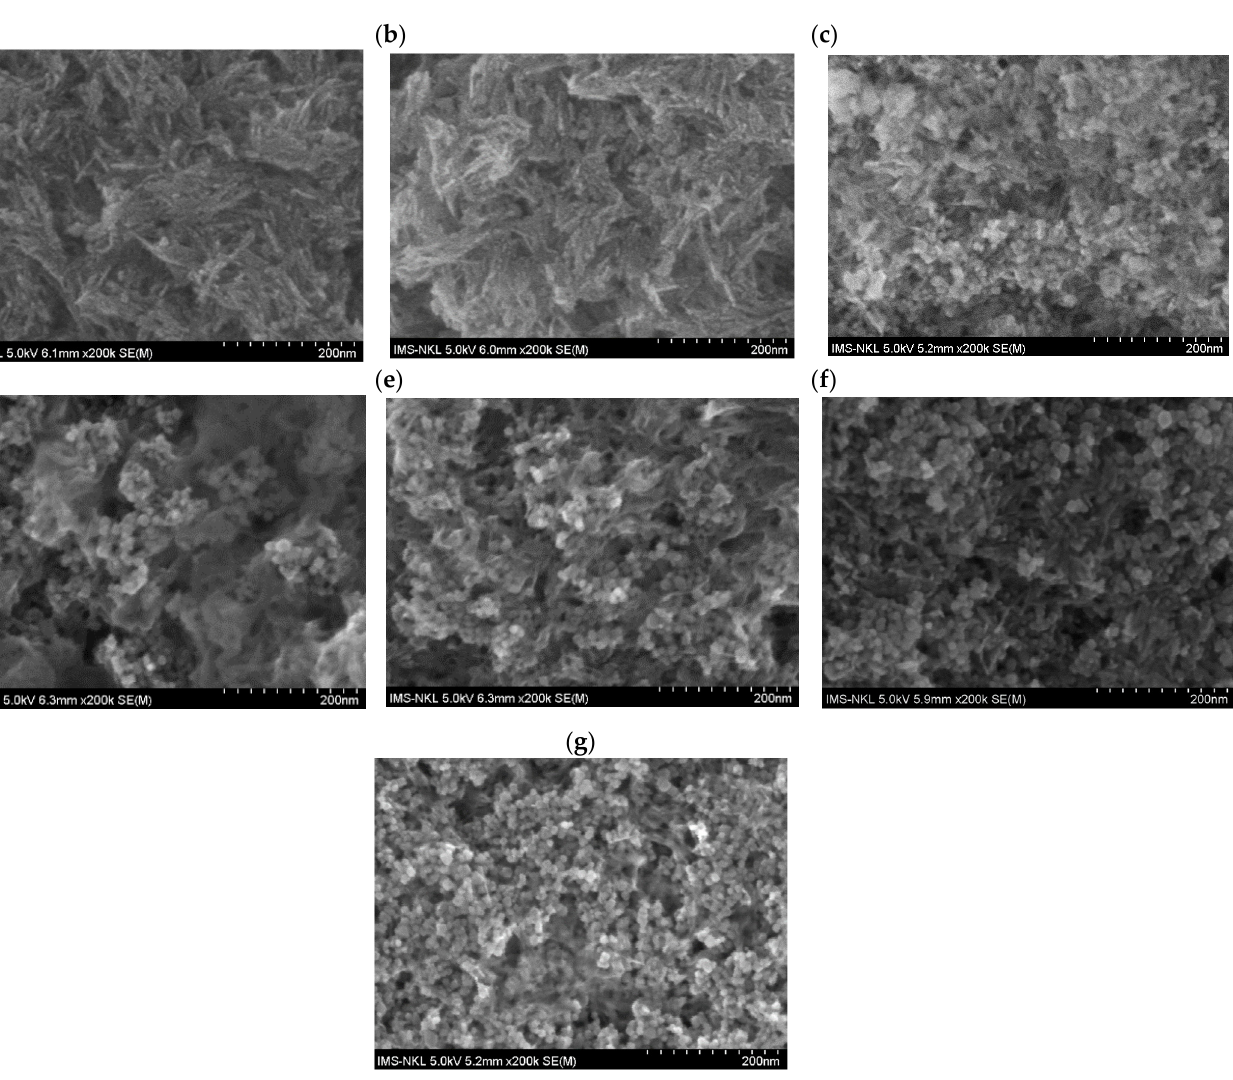
Figure 8. SEM images of SPION/HAp prepared at 80 °C with pH 11, where HAp consists ( a ) 90%, ( b ) 80%, ( c ) 50%, ( d ) 40%, ( e ) 30%, ( f ) 20%, and ( g ) 10% of wt% over SPIONs in nanocomposite.